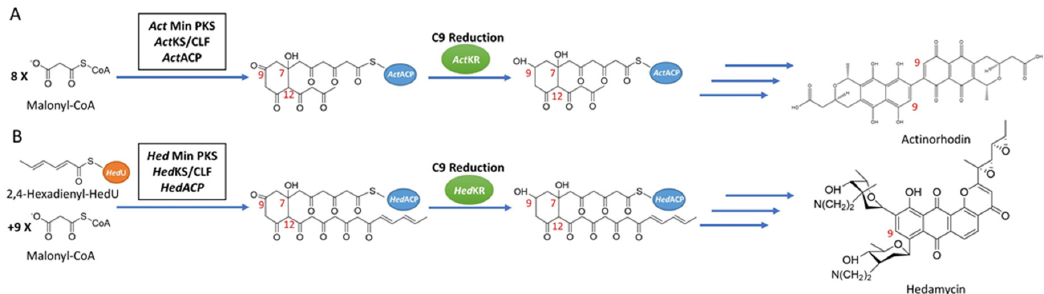
Figure 1. Synthesis pathways of reducing type II PKSs, using hedamycin and actinorhodin